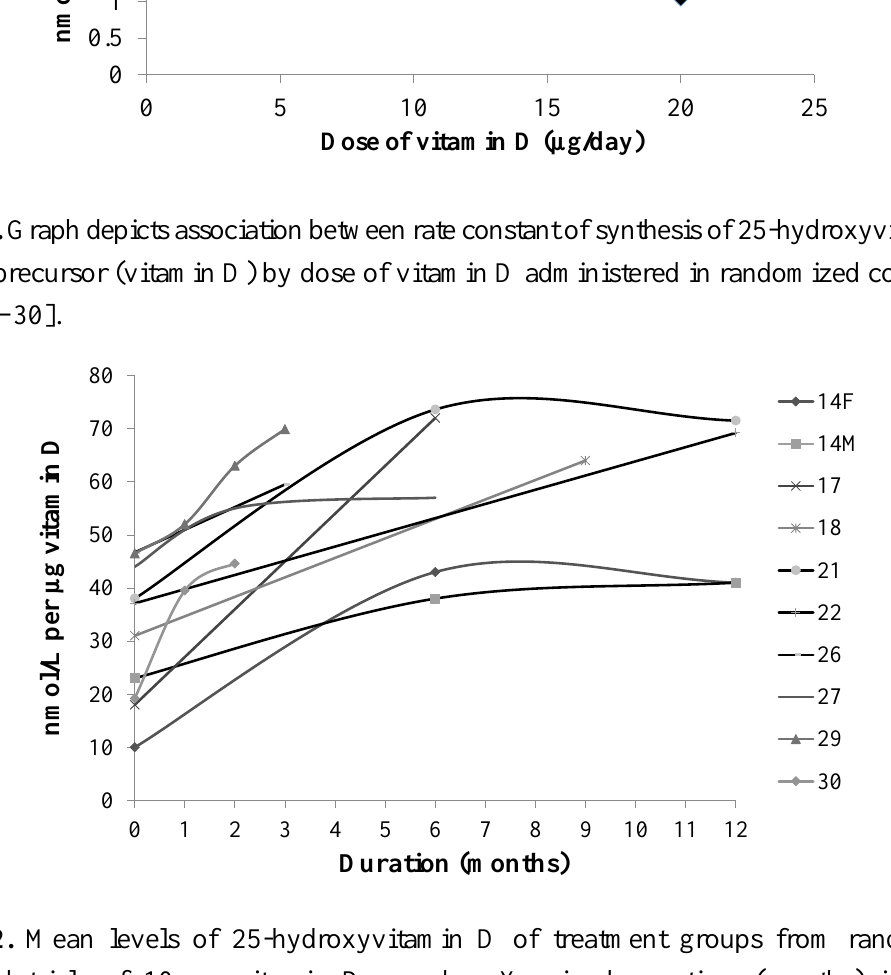
Figure 2. Mean levels of 25-hydroxyvitamin D of treatment groups from randomized controlled trials of 10 μg vitamin D per day. X-axis shows time (months) in